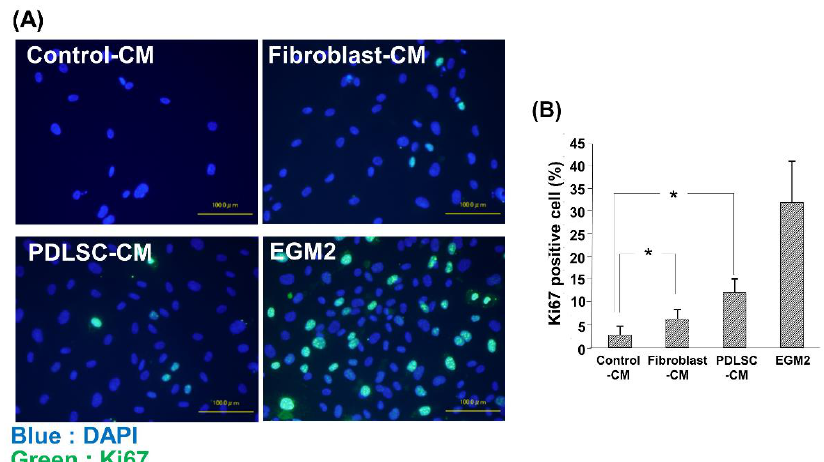
Figure 4. Ki67 staining of HUVECs cultured in various CMs. Representative merged images of Ki67 and nucleus (DAPI) staining in HUVECs cultured in Control-CM, Fibroblast-CM, PDLSC-CM, and EGM2 ( A ). The number of proliferating HUVECs was examined using Ki67 immunostaining ( B ). Quantification of the ratio of Ki67-positive cells. An increased number of Ki67-positive cells was observed in HUVECs cultured with PDLSC-CM compared to Control-CM. HUVECs cultured in EGM2 served as positive control. (* p < 0.05) (HUVECs = human umbilical cord vein endothelial cells, DAPI = 4 (cid:48) ,6-Diamidino-2- phenylindole dihydrochloride, CM = conditioned medium, PDLSC = periodontal ligament stem cells, EGM2 = endothelial cell growth medium 2). Data from an independent experiment performed three times were shown. ( n =